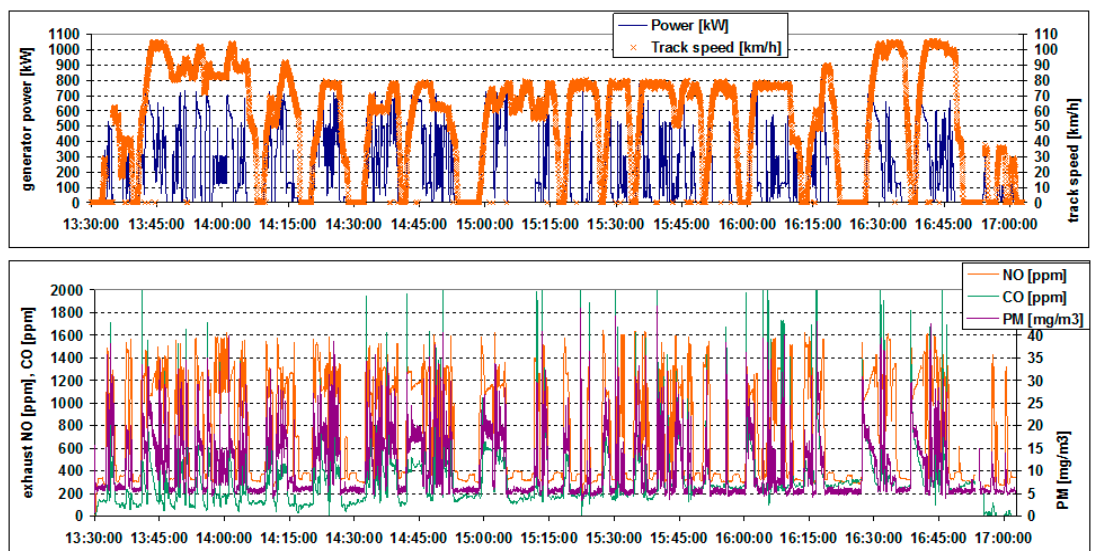
Figure 8. Measured values of running speed and generator power output (top); and concentrations of NO x , PM, and CO in the exhaust (bottom) of the Č KD 749 diesel-electric locomotive pulling a two-car, 160-ton passenger train on the Praha– Č eské Bud ě jovice line.